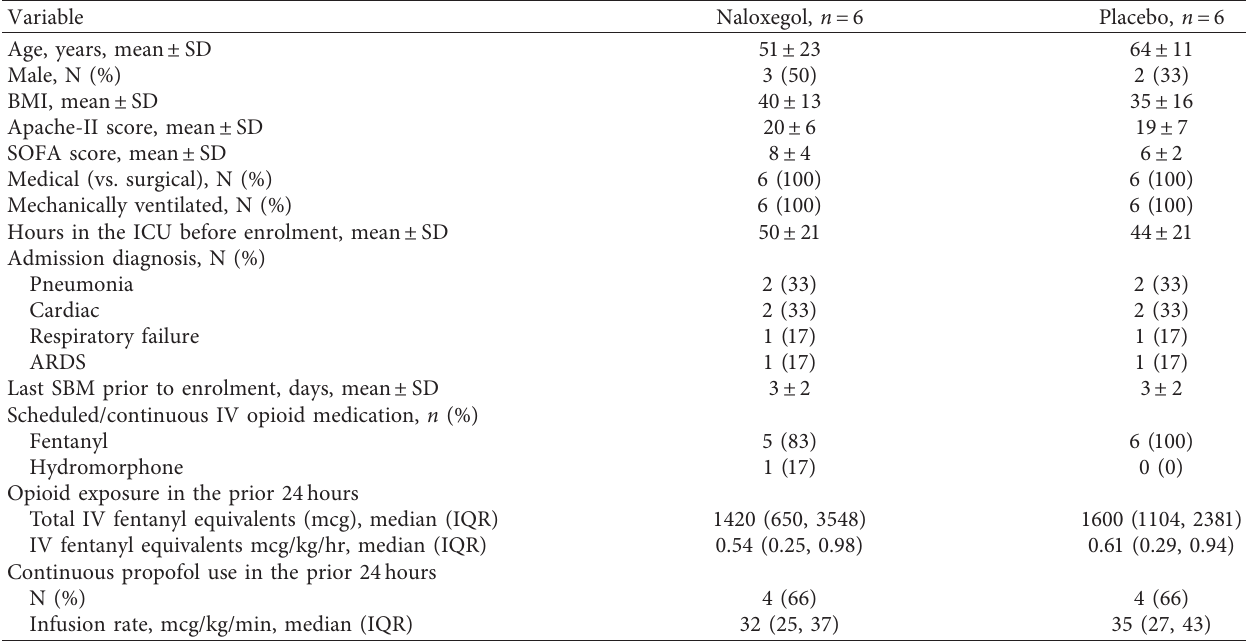
Table 2: Patient characteristics at